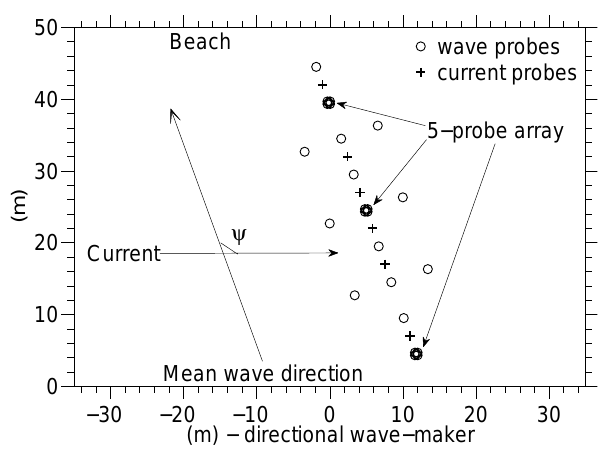
Fig. 1. Schematic representation of the laboratory